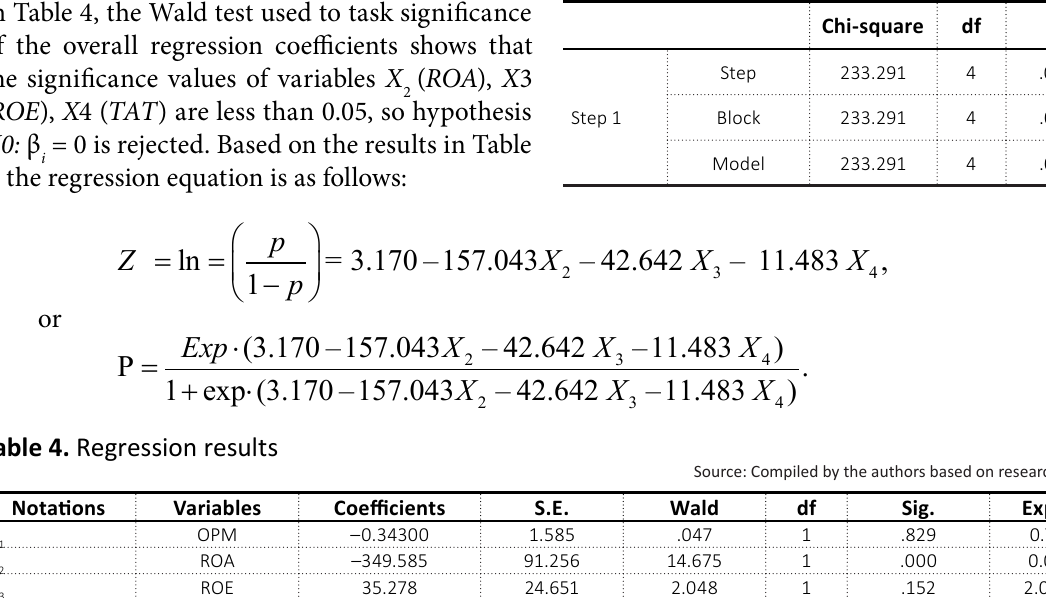
Table 5. Assessing the fit of the regression model